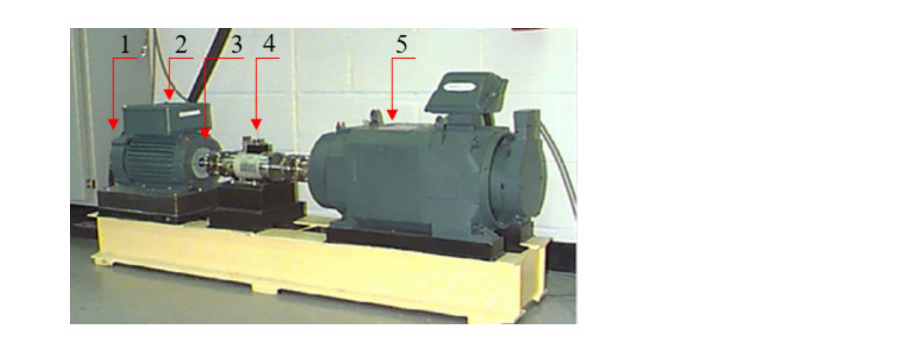
Figure 10. The test stand: 1. Fan end bearing; 2. Electric motor; 3. Drive end bearing; 4. Torque transducer/encoder; 5. Dynamometer. Table 1. Bearing specifications.